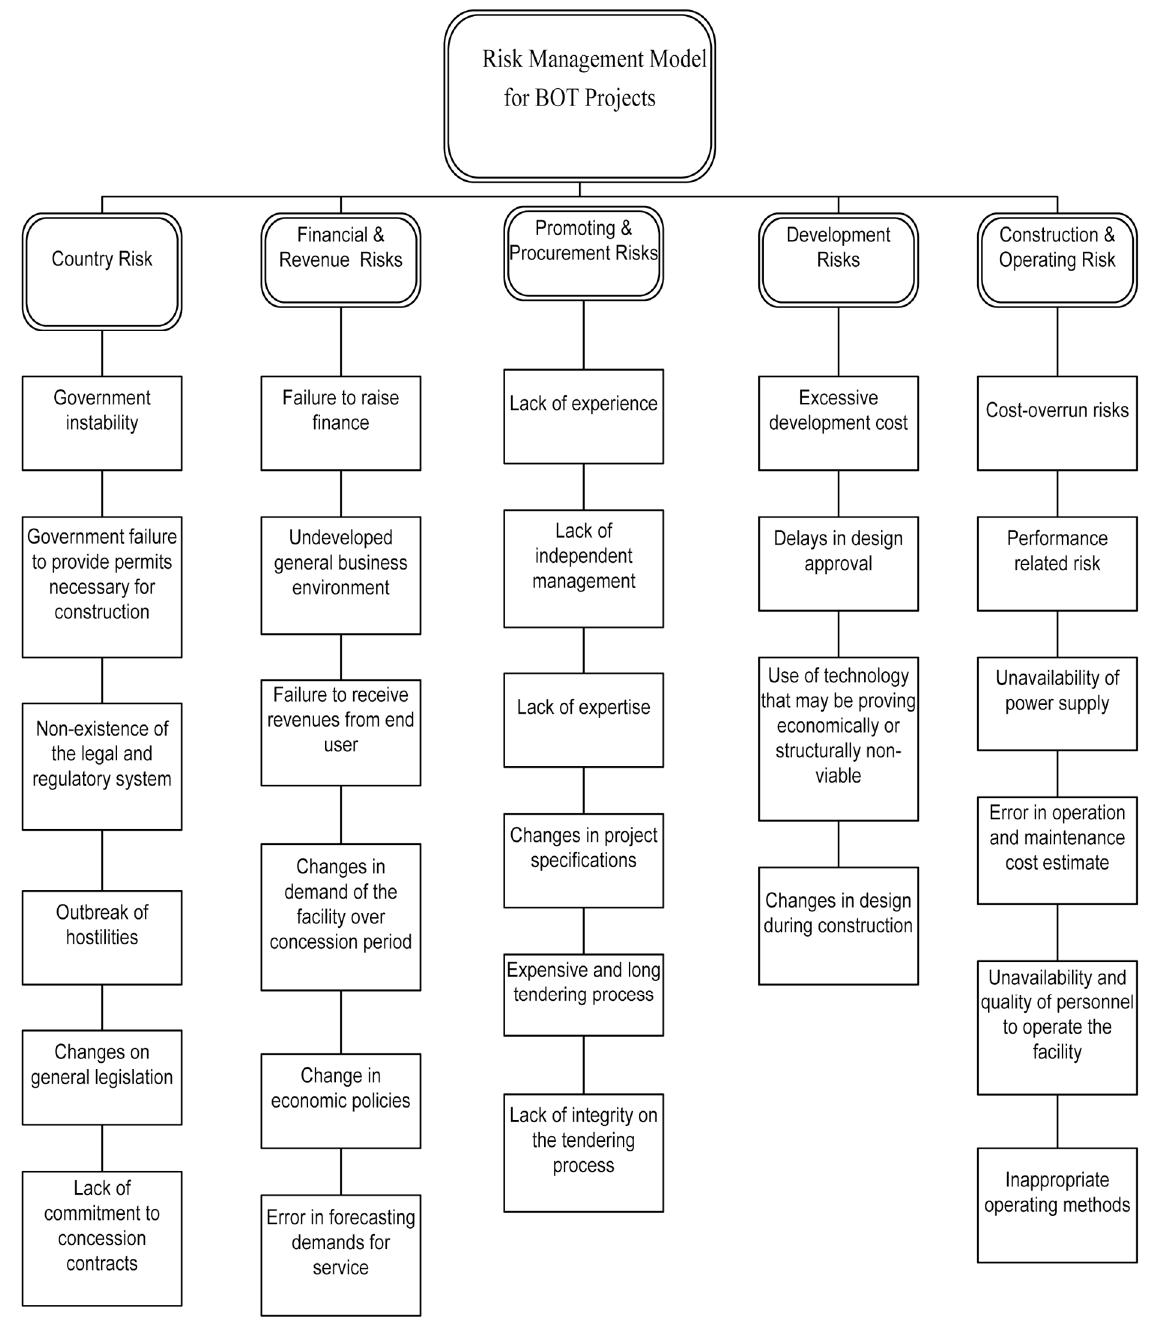
Fig. 2. Hierarchical structure of BOT project risk management